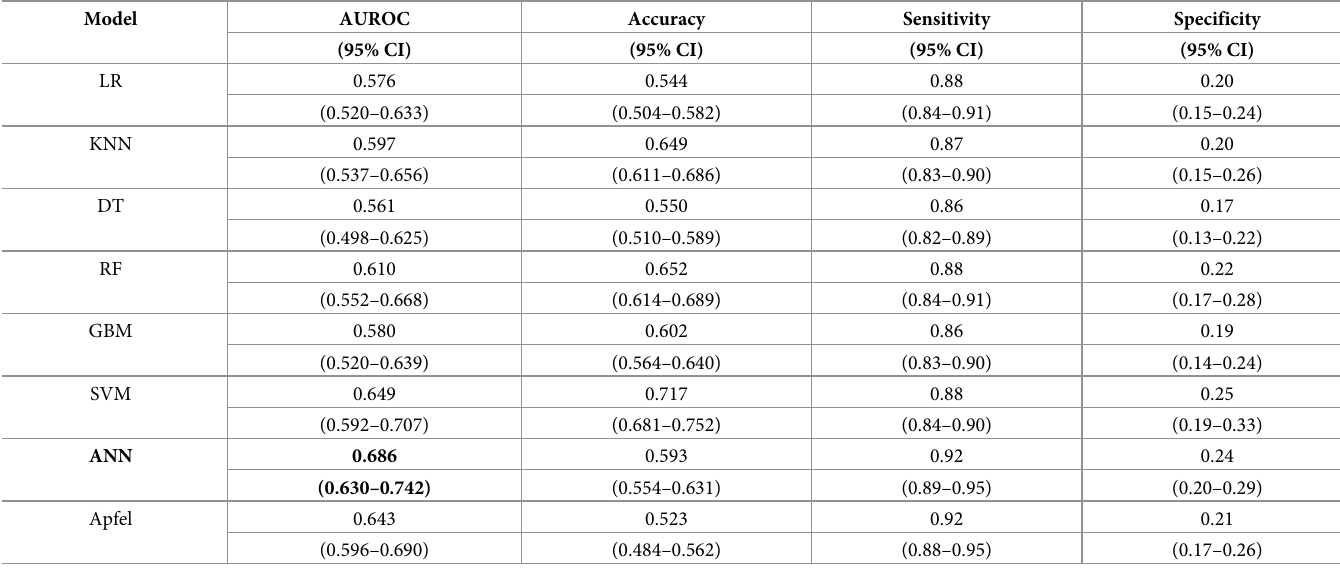
Table 3. Performance of the machine learning and Apfel